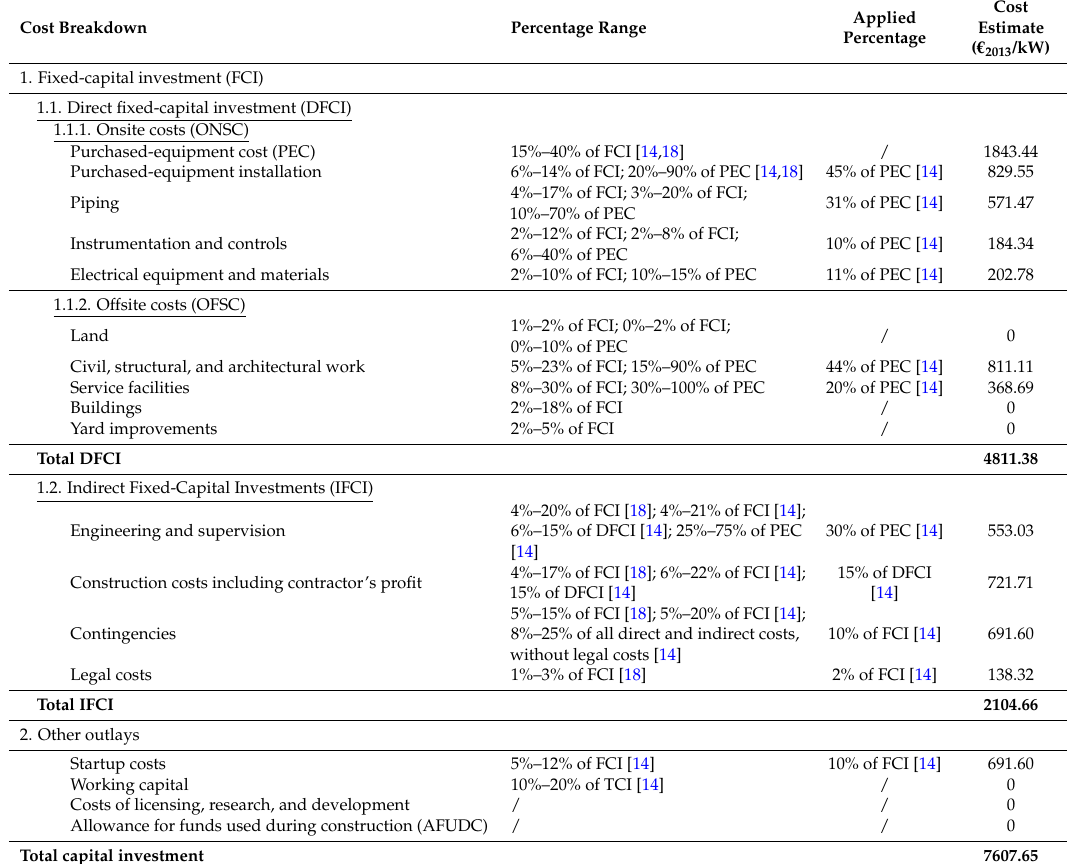
Table 6. Total investment costs estimation using percentages of delivered equipment